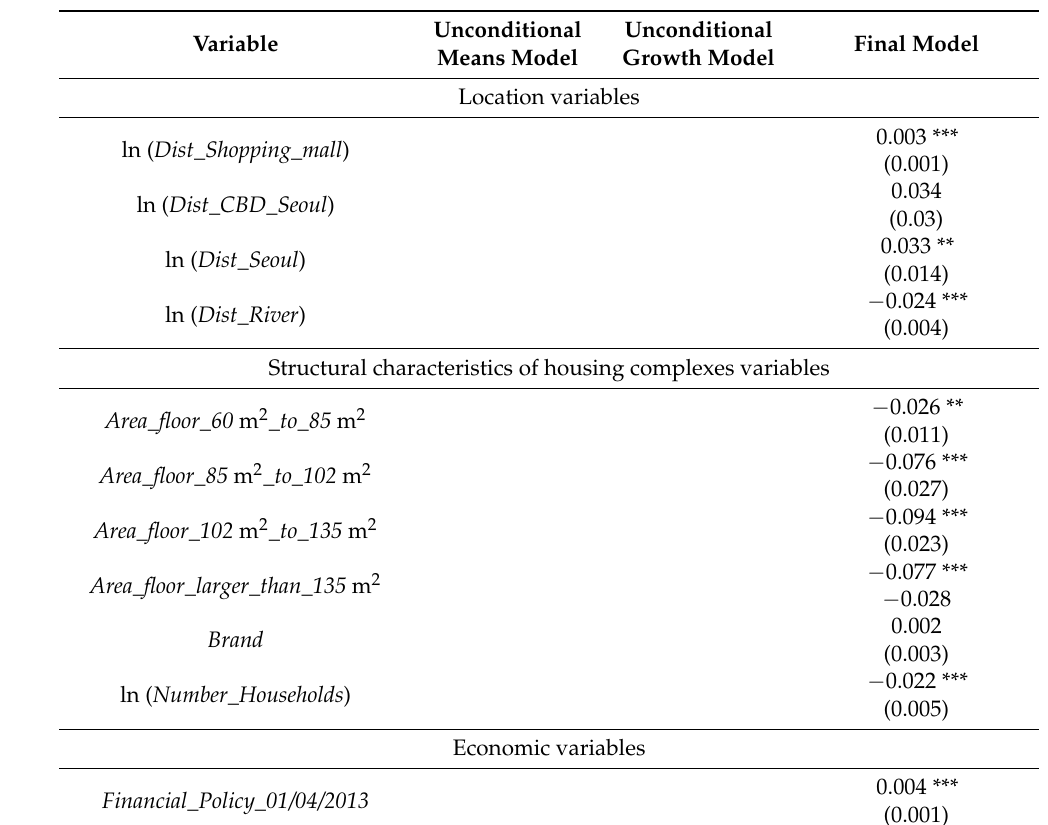
Table 2. Results of multilevel growth model including other